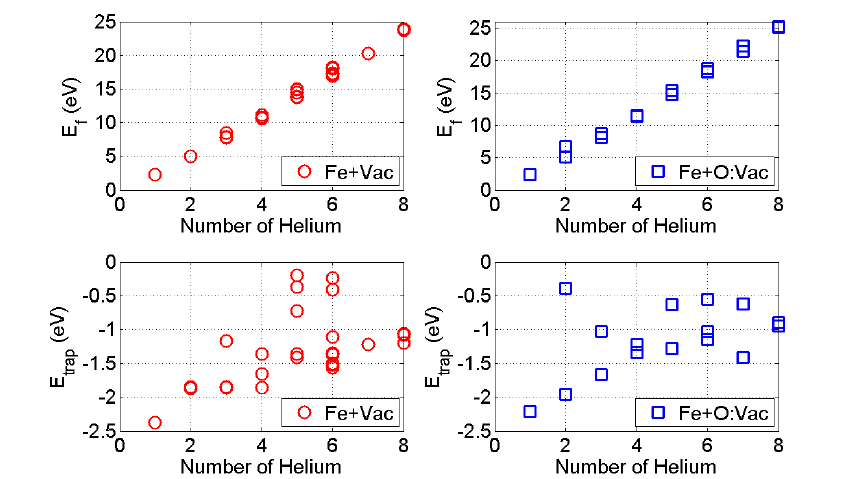
Figure 4. Formation energy and He trapping energy variation with n in the He n X cluster: X = Fe + Vac (red circles); and X = Fe + O:Vac (blue